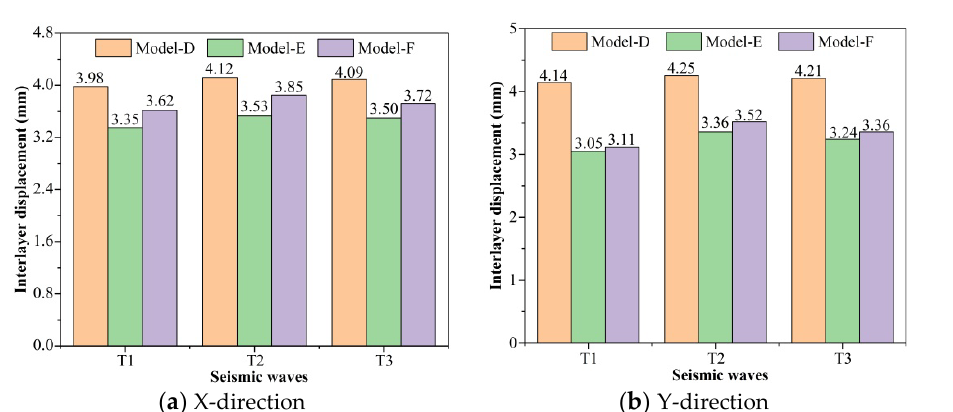
Figure 16. A comparison of the maximum interlayer displacement of the models.